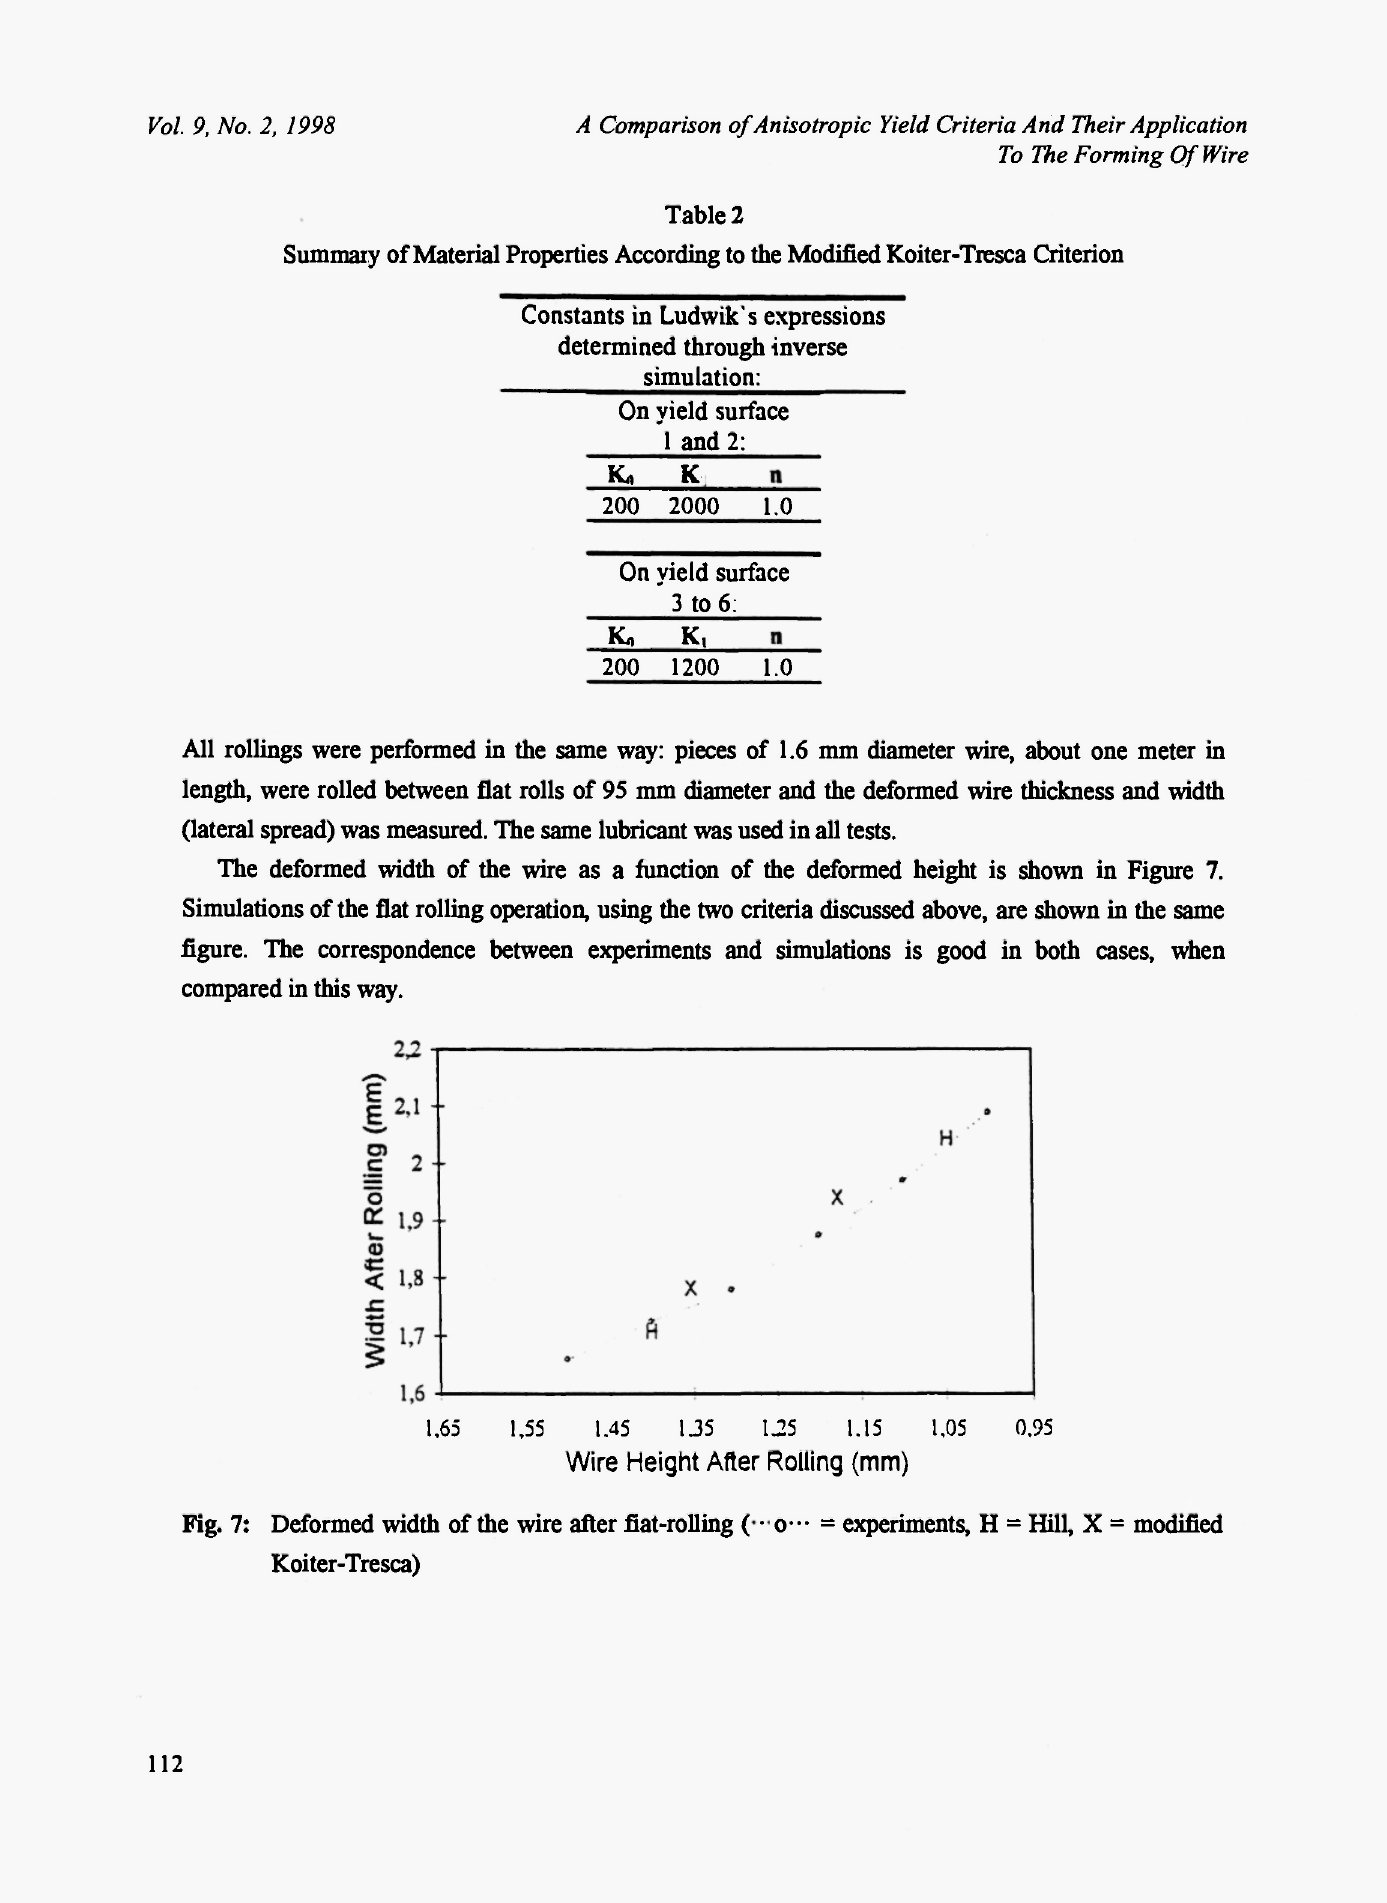
Fig. 7: Deformed width of the wire after fiat-rolling ( · ο · ·· = experiments, Η = Hill, X = modified